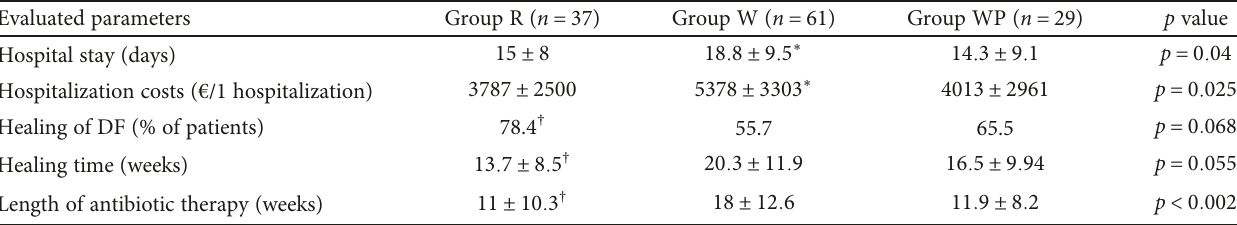
Table 2: A comparison of primary outcomes of DF healing after foot surgery among the study groups.